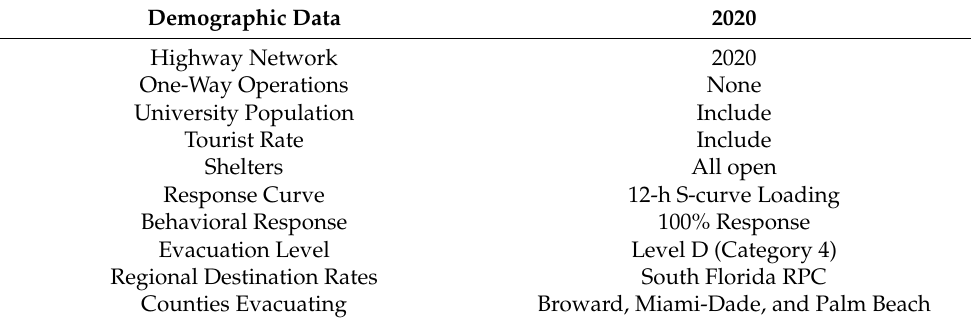
Table 3. Scenario